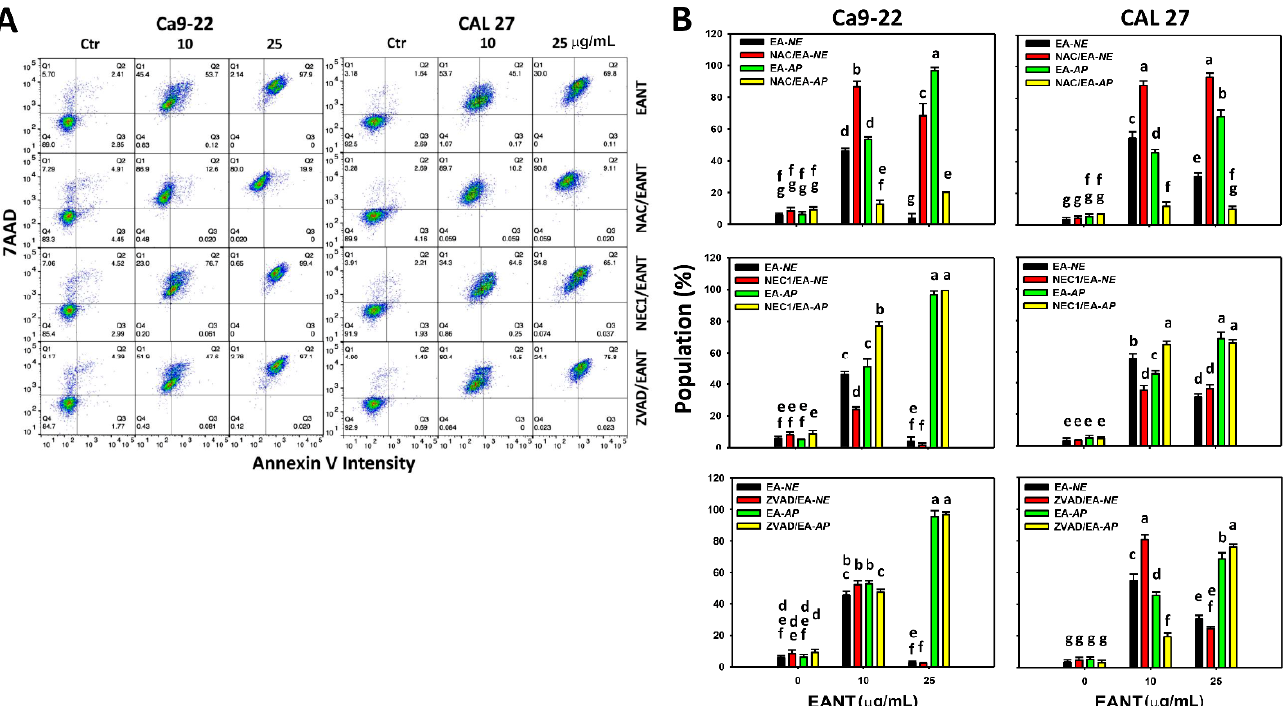
Figure 3. Annexin V/7AAD analysis. Q1, Q2, Q3, and Q4 marked in each panel indicate the necrosis, late apoptosis, early apoptosis, and lived cells, respectively. EA, EANT; NE , necrosis; AP , apoptosis (Q2 + Q3). For example, EA- NE and NAC/EA- NE indicate the necrosis ( NE ) status for EANT (EA) treatment in the absence and presence of NAC, respectively. EA- NE and NEC1/EA- NE indicate the NE status for EA treatment in the absence and presence of NEC1, respectively. EA- NE and ZVAD/EA- NE indicate the NE status for EA treatment in the absence and presence of ZVAD, respectively. ( A , B ) Annexin V/7AAD pattern and statistical analysis. With the inhibitor pretreatments for oxidative stress, necrosis, and apoptosis (10 mM NAC for 1 h, 50 µ M NEC1 for 1 h, and 100 µ M ZVAD for 2 h), or not, oral cancer cells (Ca9-22 and CAL 27) were treated with EANT (control, 10, 25 μg/mL) for 24 h. Data (mean ± SD, n = 3) showing different letters on top differ significantly for multiple comparisons ( p < 0.05). One-way analysis of variance (ANOVA) with a post hoc test was applied to multiple comparisons. For example (Ca9-22 cells in Figure 3B), the EN- NE (red color) at 0, 10, and 25 μg/mL show “fg, b, and c”, indicating significant differences among each other because they do not overlap with the same lowercase letter. Similar to 25 μg/mL EANT, EA- NE , NAC/EA- NE , EA- AP , and NAC/EA- AP show “g, c, a, and e”, indicating significant differences. In contrast, EA- NE , NAC/EA- NE , EA- AP , and NAC/EA- AP at the control (0 EANT) show “fg”, indicating nonsignificant differences between each other because they overlap with the same lowercase letter